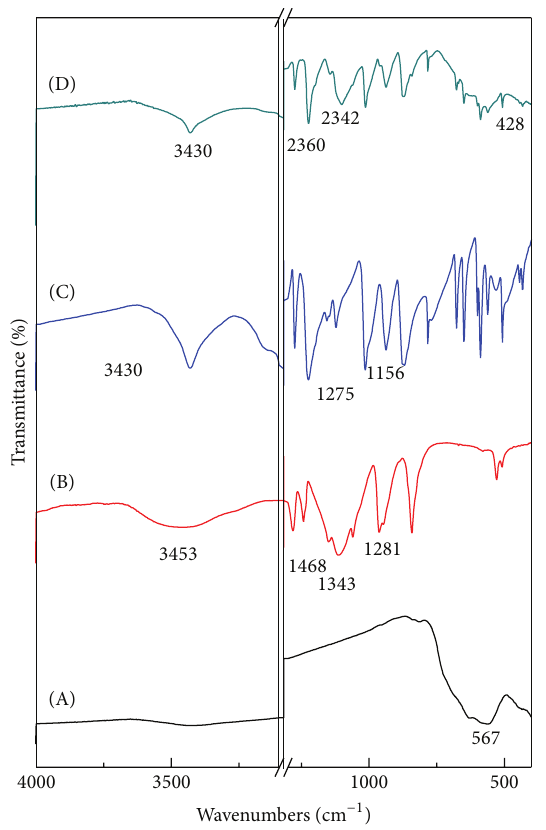
Figure 2: FTIR spectra of FNPs (A), pure PEG (B), pure MP (C), and FPEGMP-2 nanocomposite